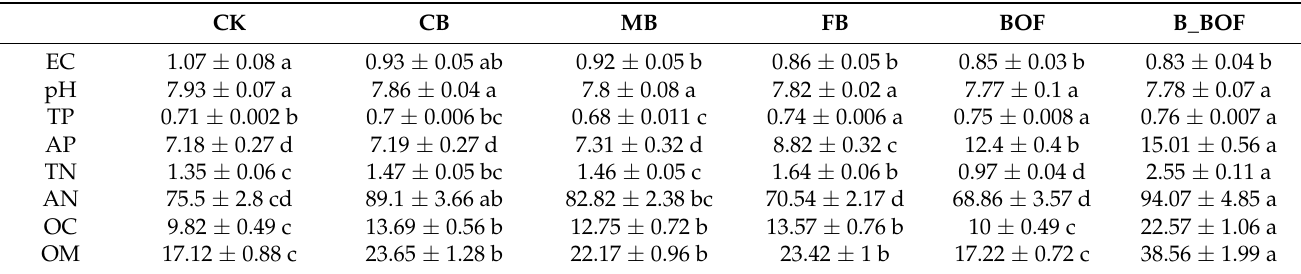
Table 1. Effect of biochar and BOF on the physical and chemical properties of